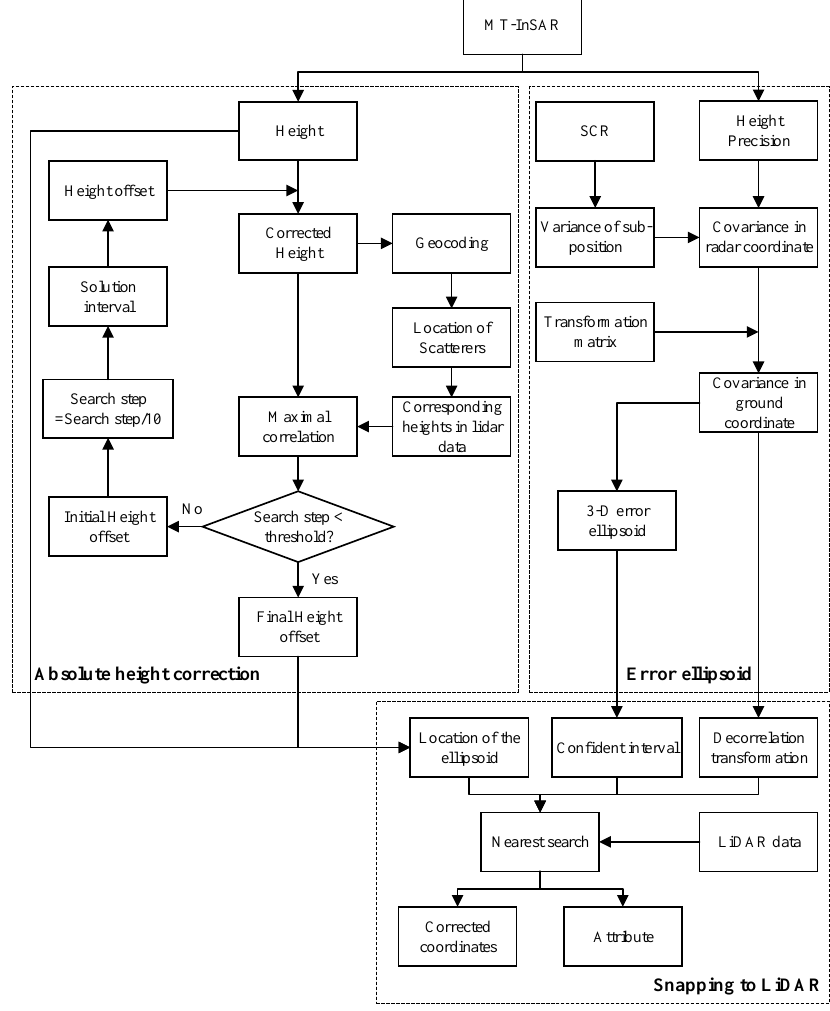
Figure 1. Flowchart of the attribution of the InSAR observations using LiDAR data. There are three main steps: (1) absolute height correction; (2) error ellipsoid estimation; and (3) snapping to the LiDAR point